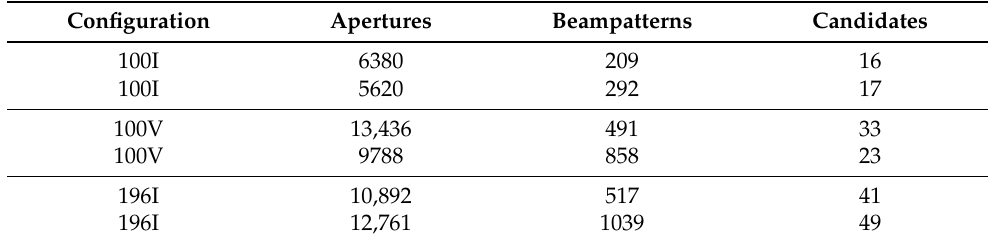
Table 3. Computational cost for different configurations. Combined fitness function.